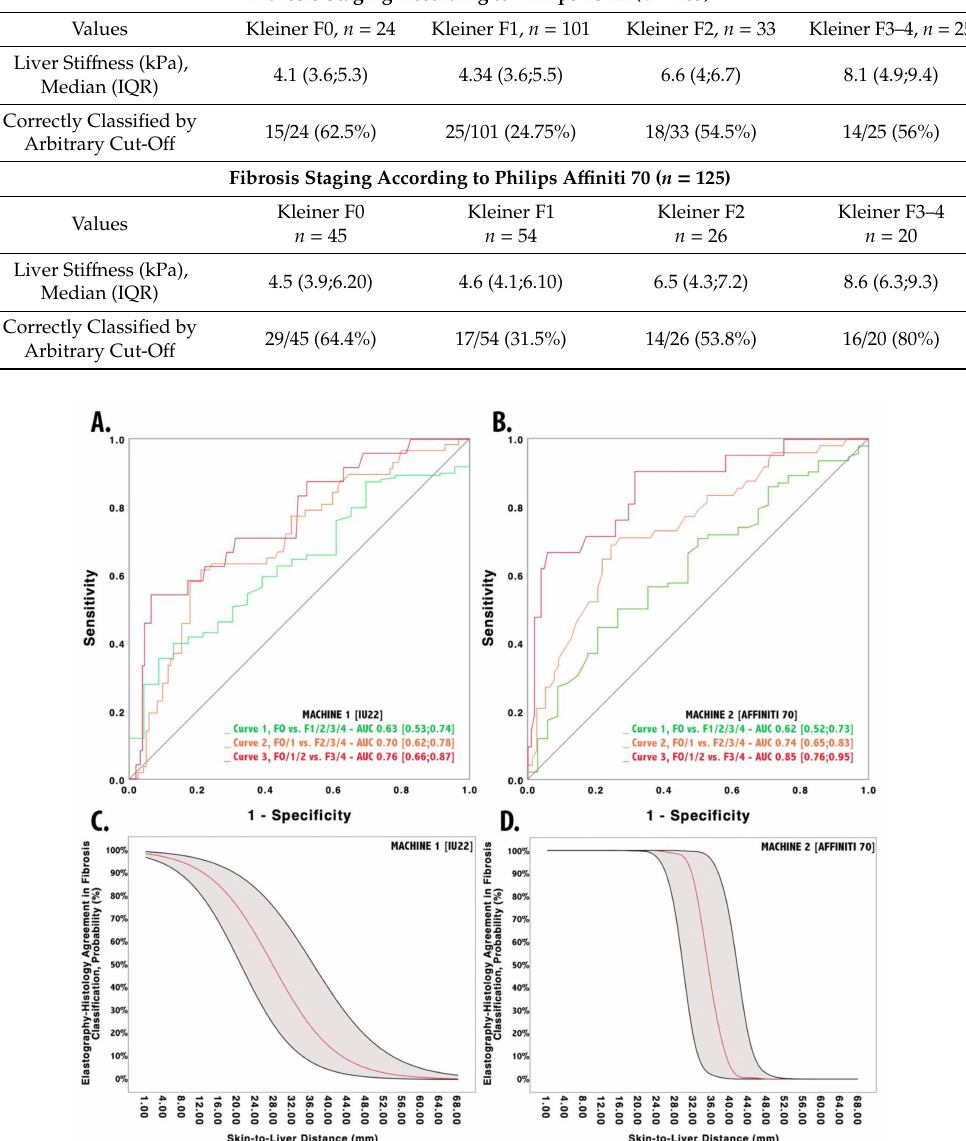
Figure 1. Discriminative ability of liver sti ff ness—measured by Philips IU22 ( A ) and Philips A ffi niti 70 ( B )—between various degrees of fibrosis. Probability of agreement between histology and elastography based on Skin-to-Liver Distance according to Philips IU22 ( C ) and Philips A ffi niti 70 ( D